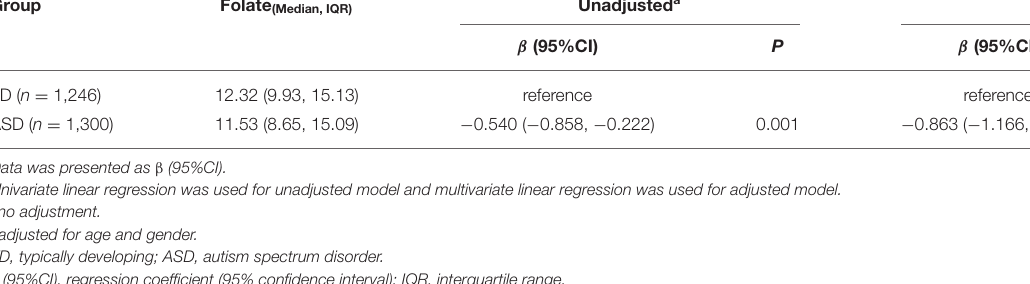
TABLE 2 | Comparison of serum folate level between TD and ASD children in different models. Group Folate (Median,IQR) Unadjusted a Adjusted b β (95%CI) P β (95%CI) P TD ( n = 1,246) 12.32 (9.93, 15.13) reference reference ASD ( n = 1,300) 11.53 (8.65, 15.09) − 0.540 ( − 0.858, − 0.222) 0.001 − 0.863 ( − 1.166, − 0.559) <